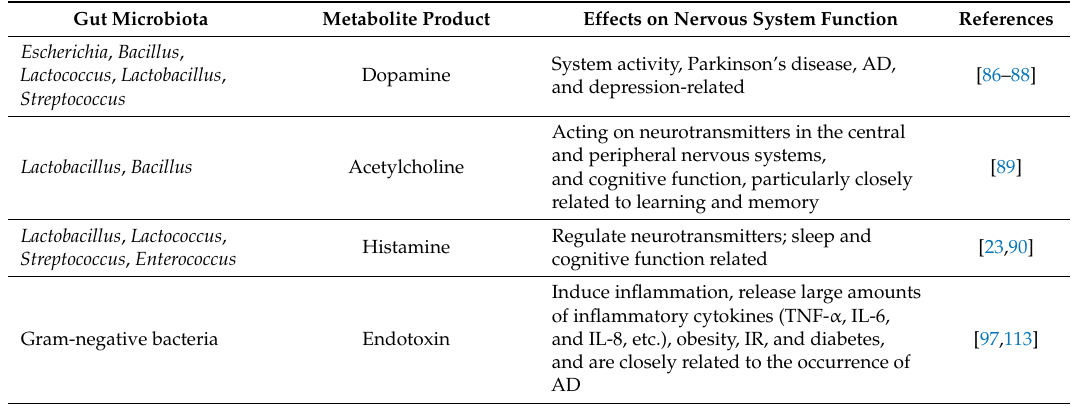
Table 2. Potential links between gut microbiota and the development of Alzheimer’s disease (AD). Gut